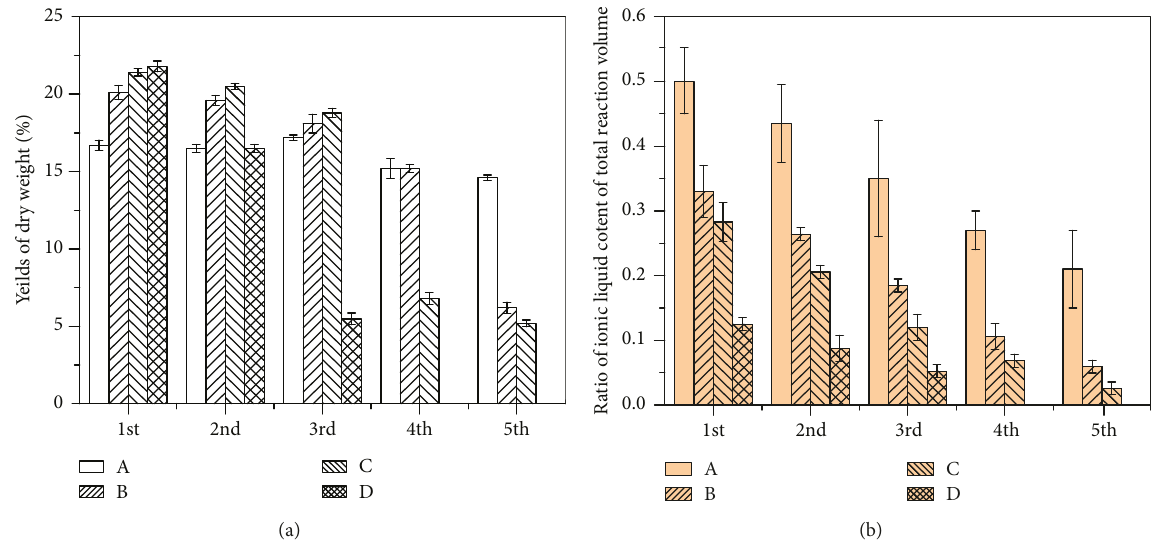
Figure 6: The in fl uence of recycle times of [BMIM]MeSO